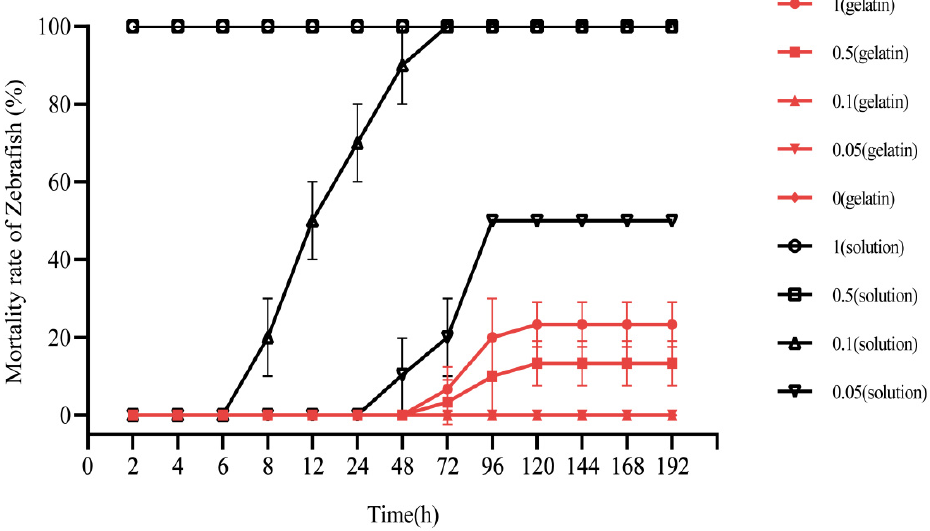
Figure 7. Mortality rates of zebrafish exposed to niclosamide under different concentrations of niclosamide gelatin or solution (%) (red line). Zebrafish exposed to niclosamide under 1 mg/L niclosamide gelatin (circle), 0.5 mg/L niclosamide gelatin (square), 0.1 mg/L niclosamide gelatin (equilateral triangle), 0.05 mg/L niclosamide gelatin (inverted triangle), and gelatin without niclosamide (diamond). Zebrafish (black line) exposed to niclosamide under 1 mg/L niclosamide solution (circle), 0.5 mg/L niclosamide solution (square), 0.1 mg/L niclosamide solution (equilateral triangle), and 0.05 mg/L niclosamide solution (inverted triangle). Three red lines of 0.1, 0.05 and 0 mg/L niclosamide gelatin are overlapped because the mortality rates of zebrafish were the same.